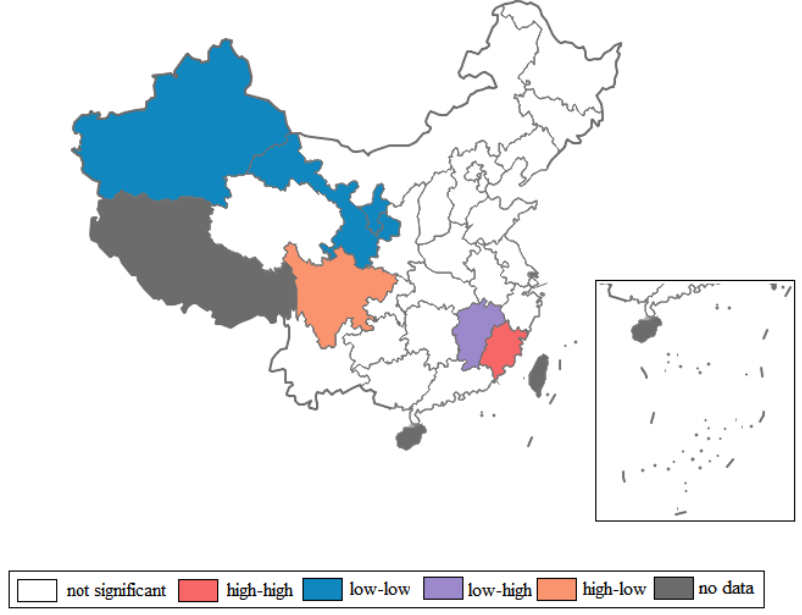
Figure 1. Spatial aggregation of urban residents’ electricity consumption in 20 06.